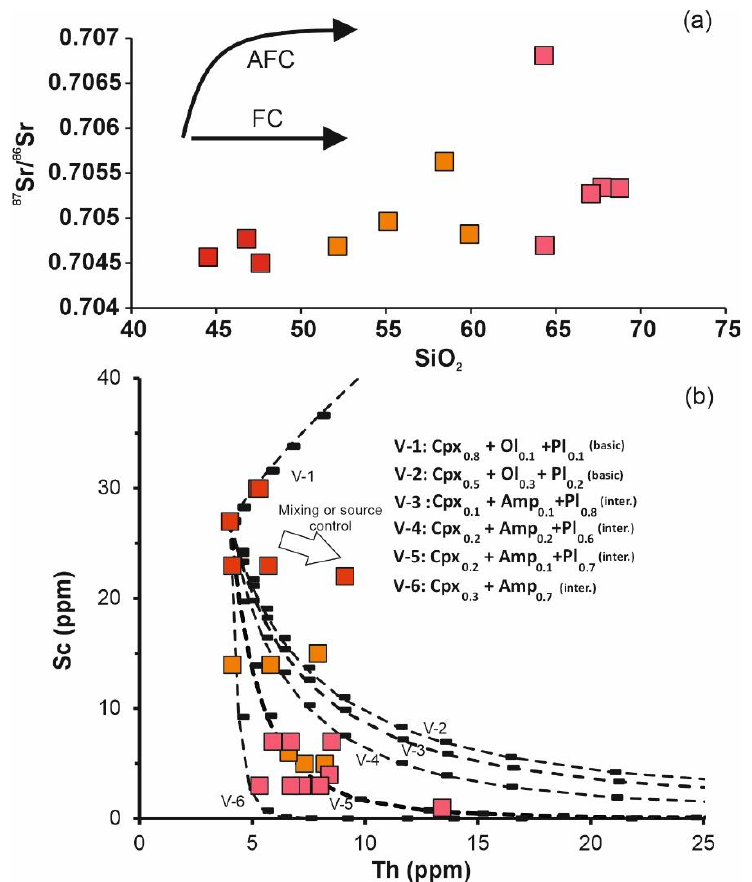
Figure 14. ( a ) 87 Sr/ 86 Sr vs. SiO 2 contents of the SNV; ( b ) Th vs. Sc bivariate diagram displaying theoretical Rayleigh fractional crystallization curves depending on phase combinations inserted. Kd values for different minerals were taken from http://earthref.org (accessed on 5 October 2022) and are given in Supplementary Data. Tick marks on each curve correspond to 5% crystallization